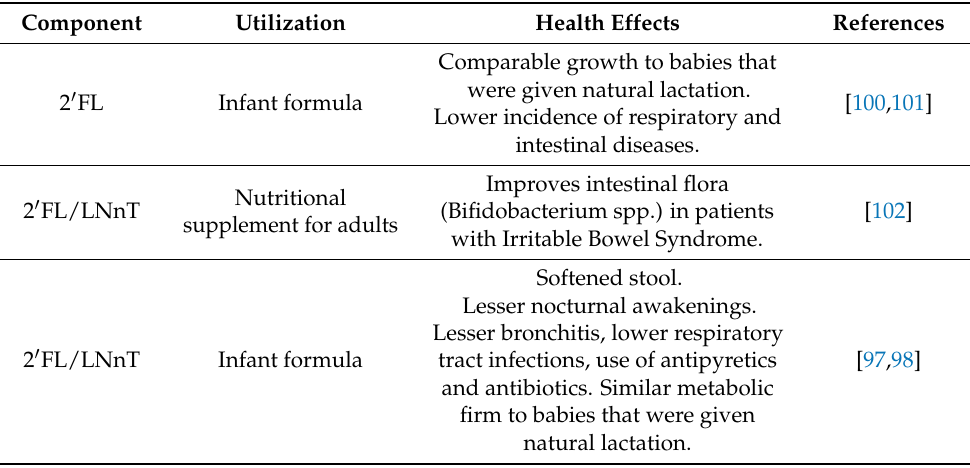
Table 2. Examining human milk oligosaccharides (HMOs) breast milk components used in health applications, summary of evidences (clinical trials, cohort studies, and